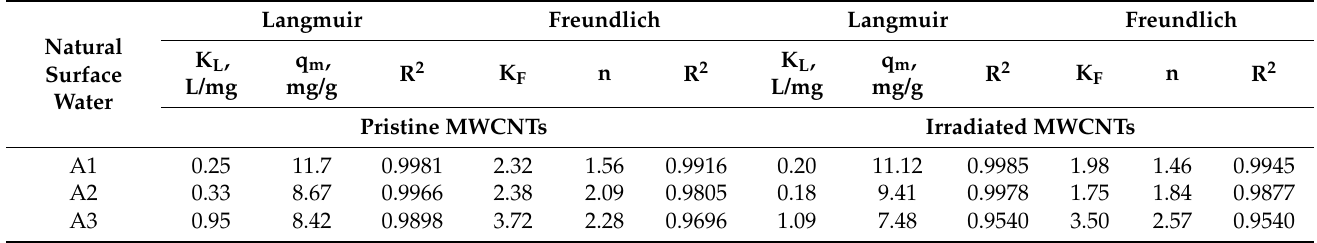
Figure 3. Langmuir and Freundlich non-linear adsorption isotherms in natural surface water A3 at 25 °C ( a ) and 5 °C ( b ). Table 2. Parameters for the adsorption of TCC on MWCTs in natural surface waters at 5 °C. Table 3. Parameters for the adsorption of TCC on MWCTs in natural surface waters at 25 ◦